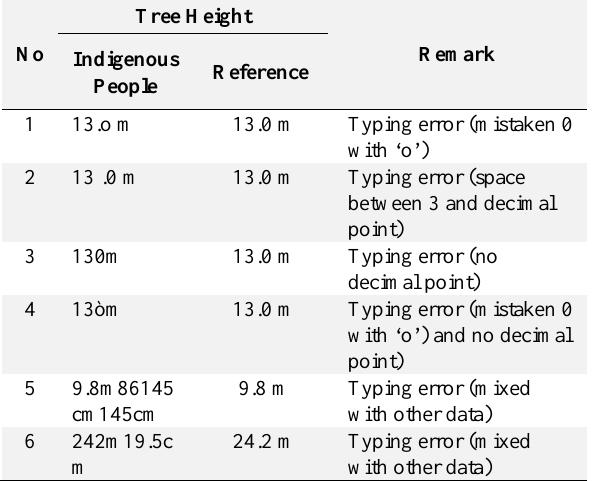
Table 9. A list of errors detected in data entry of tree height (in task 1) against the reference data.